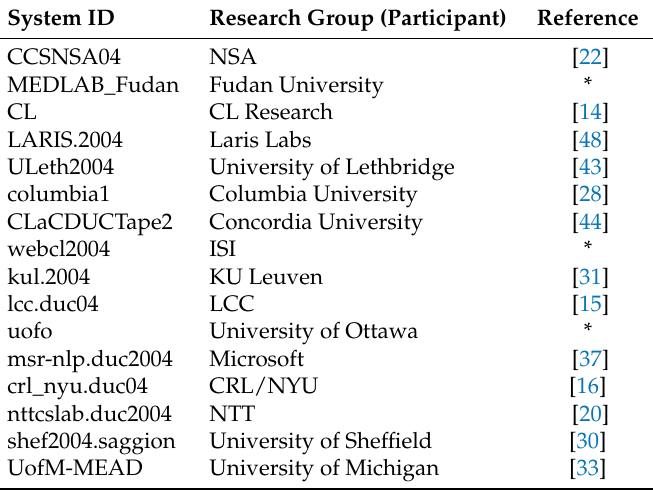
Table 2. Systems that participated at DUC 2004 (Task